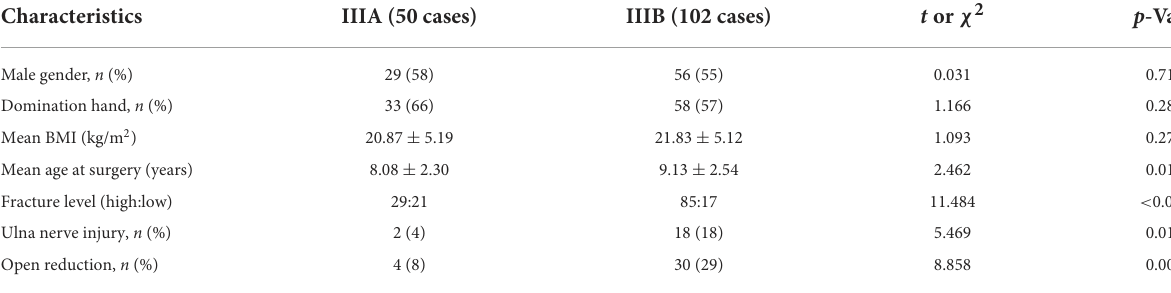
TABLE 1 Injury characteristics of 152 skeletally immature patients with lateral flexion supracondylar humerus fractures (SCHF).